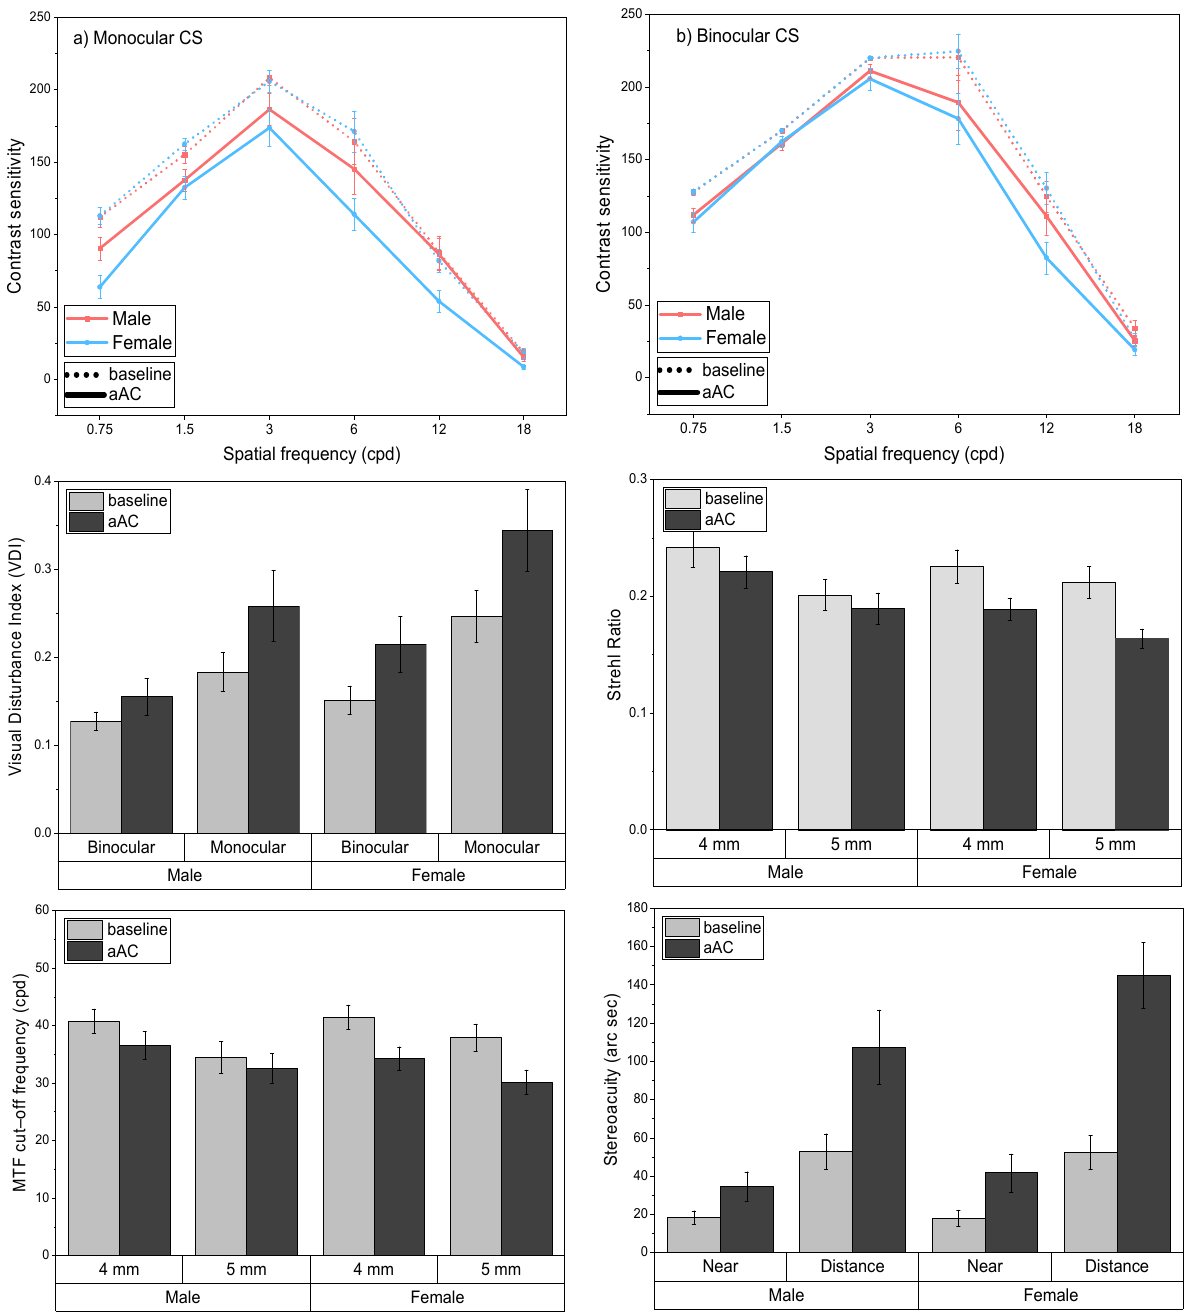
Figure 2. Mean contrast sensitivity function, visual deterioration index (VDI), stereopsis (near and distance stereoacuity), and retinal image quality (MTF cut-off and Strehl Ratio) in males and females. Standard errors included.